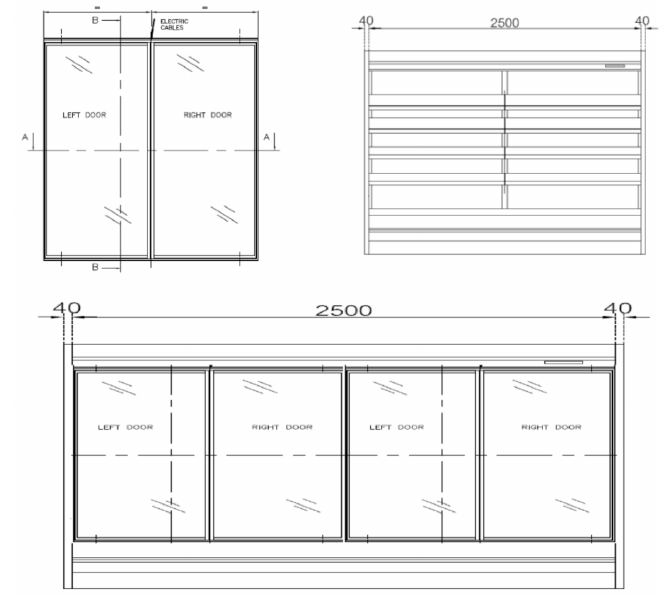
Figure 1. Low-E glass door